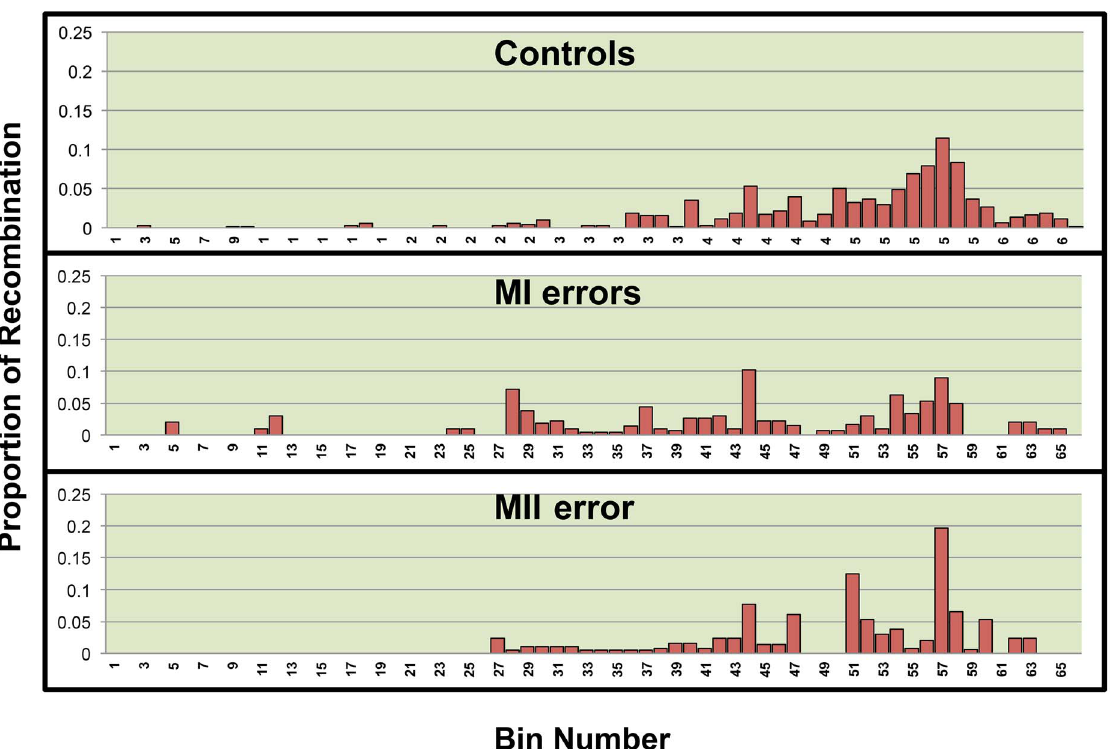
Figure 3. The distribution of the distal recombinant of a double recombinant event across the long arm of 21q by population. 21q was divided into 66 500 kb bins and the distribution of recombination in each bin from the distal recombinant event of chromosomes displaying two recombinant events is depicted above.